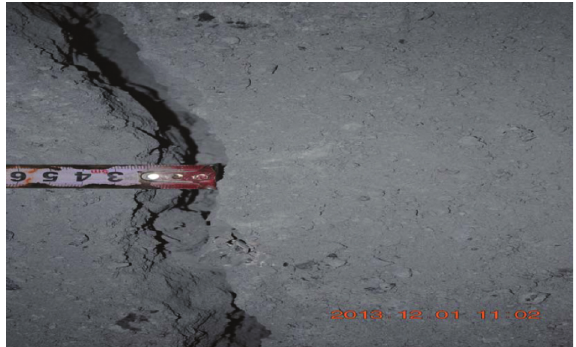
Figure 1: Project location.